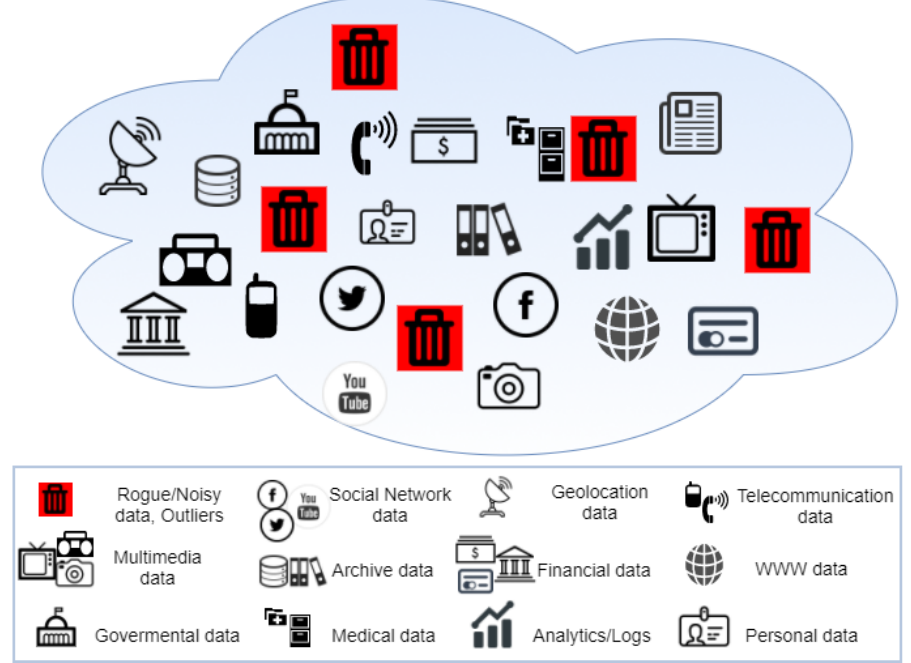
Figure 3. Ocean of Data